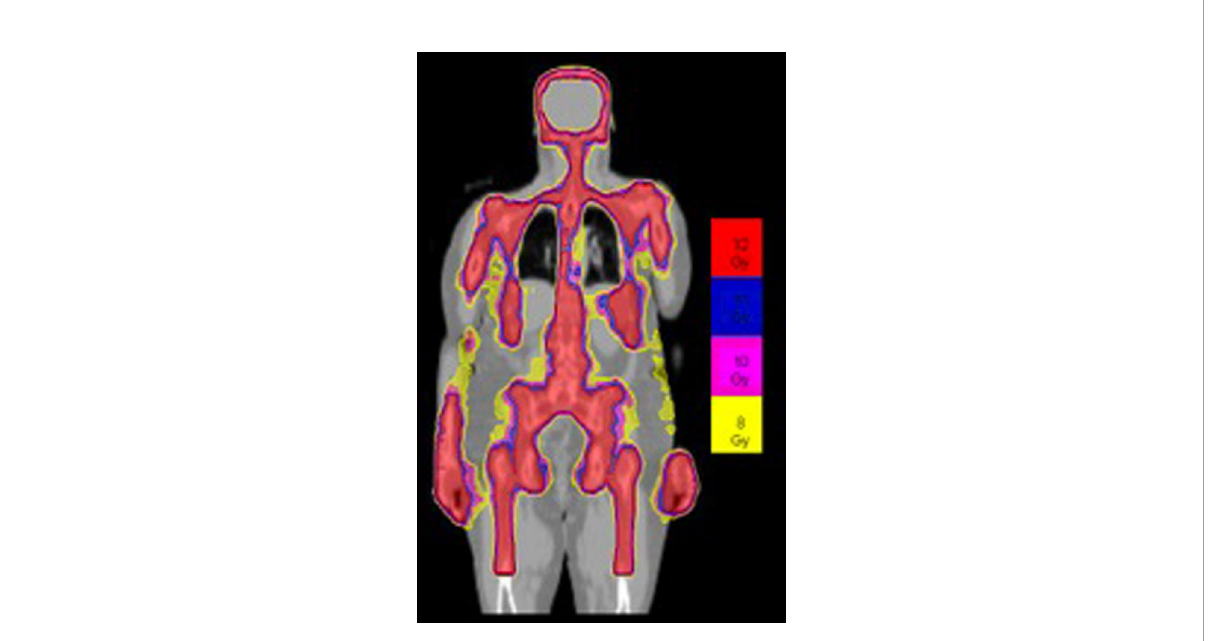
FIGURE 1 Color-coded TMLI plan shows dose to the targeted areas, with relative sparing of dose to critical